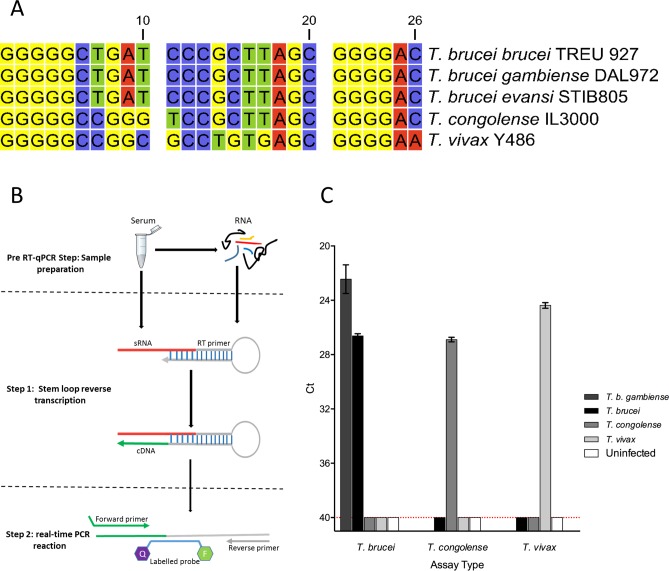
7SL-sRNA sequence enables differentiation between animal-infective trypanosome species.A) The 26-bp 7SL-sRNA sequence identified in T. congolense serum was aligned to that from other trypanosomatids, revealing species-specific differences that were flanked by conserved guanosine repeats. The polymorphisms were utilised to design species-specific Taqman RT-qPCR assays. B) Schematic representation of the Taqman RT-qPCR assay, a 2 step based assay that makes use of step-loop primers as previously described in [56]. C) Assays generated for the detection of T. b. brucei, T. vivax and T. congolense were applied to RNA samples extracted from plasma from infected animals, adjudged to exhibit similar parasitaemia scores. In each case, only the species for which the assay was designed was detected by RT-qPCR and were statistically significant (alpha = 0.05) as determined by Wilcoxon Signed Rank test, P value (two tailed) <0.0001 and n = 4. Red dotted line indicates limit of detection. The T. brucei assay was also tested on RNA extracted from T. b. gambiense culture supernatants (n = 3, average cell density of 1.56 x 106 cells/mL).